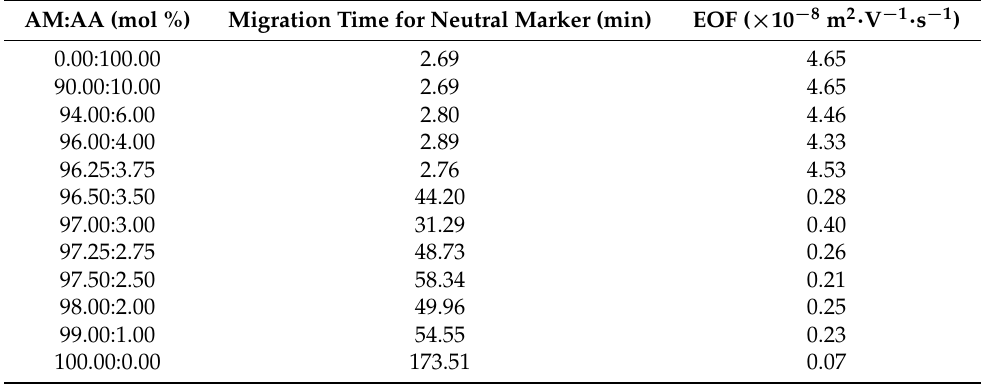
Table 3. Electroosmotic flow (EOF) values obtained for poly(AM- co -AA) coatings with different AA contents by using a solution of neutral coumarin